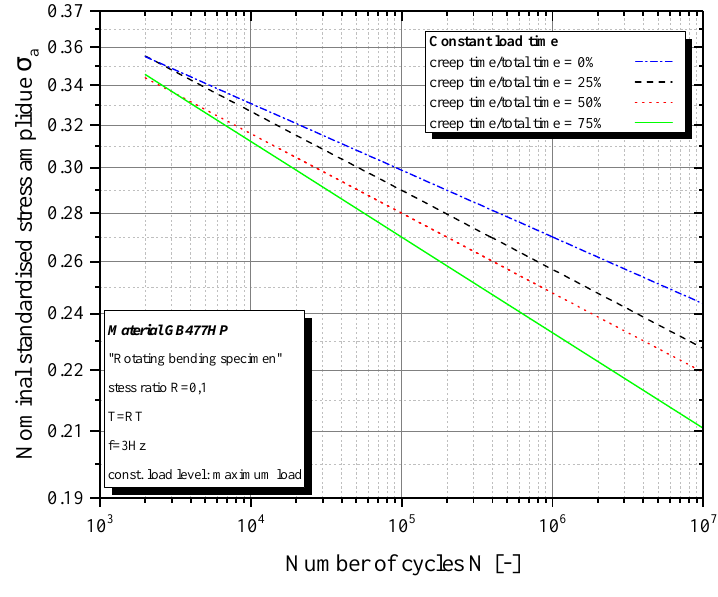
Figure 5. Influence of the constant load share on the